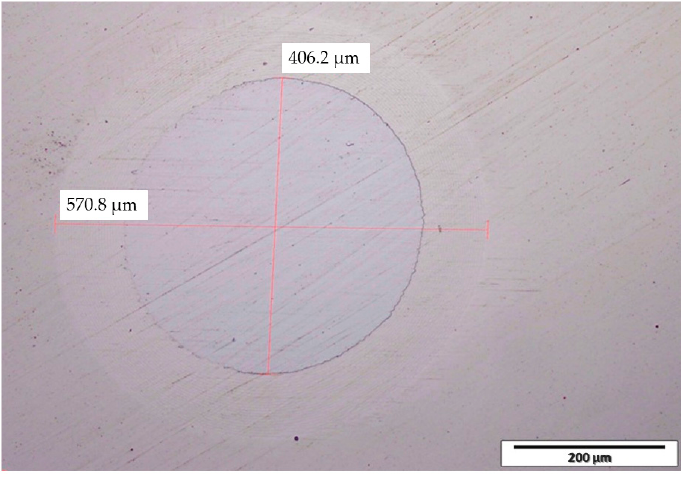
Figure 19. Calotte on sample SH-15 after Calotest testing.